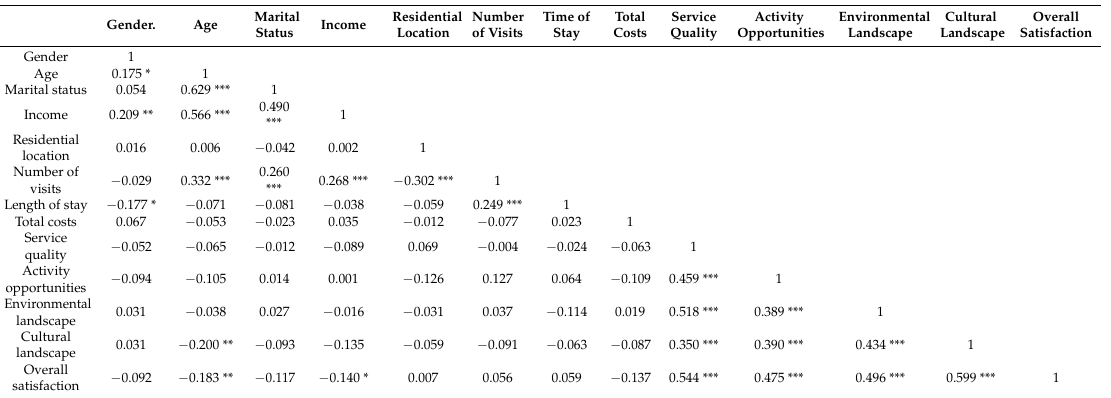
Table 10. Correlation analysis between variable